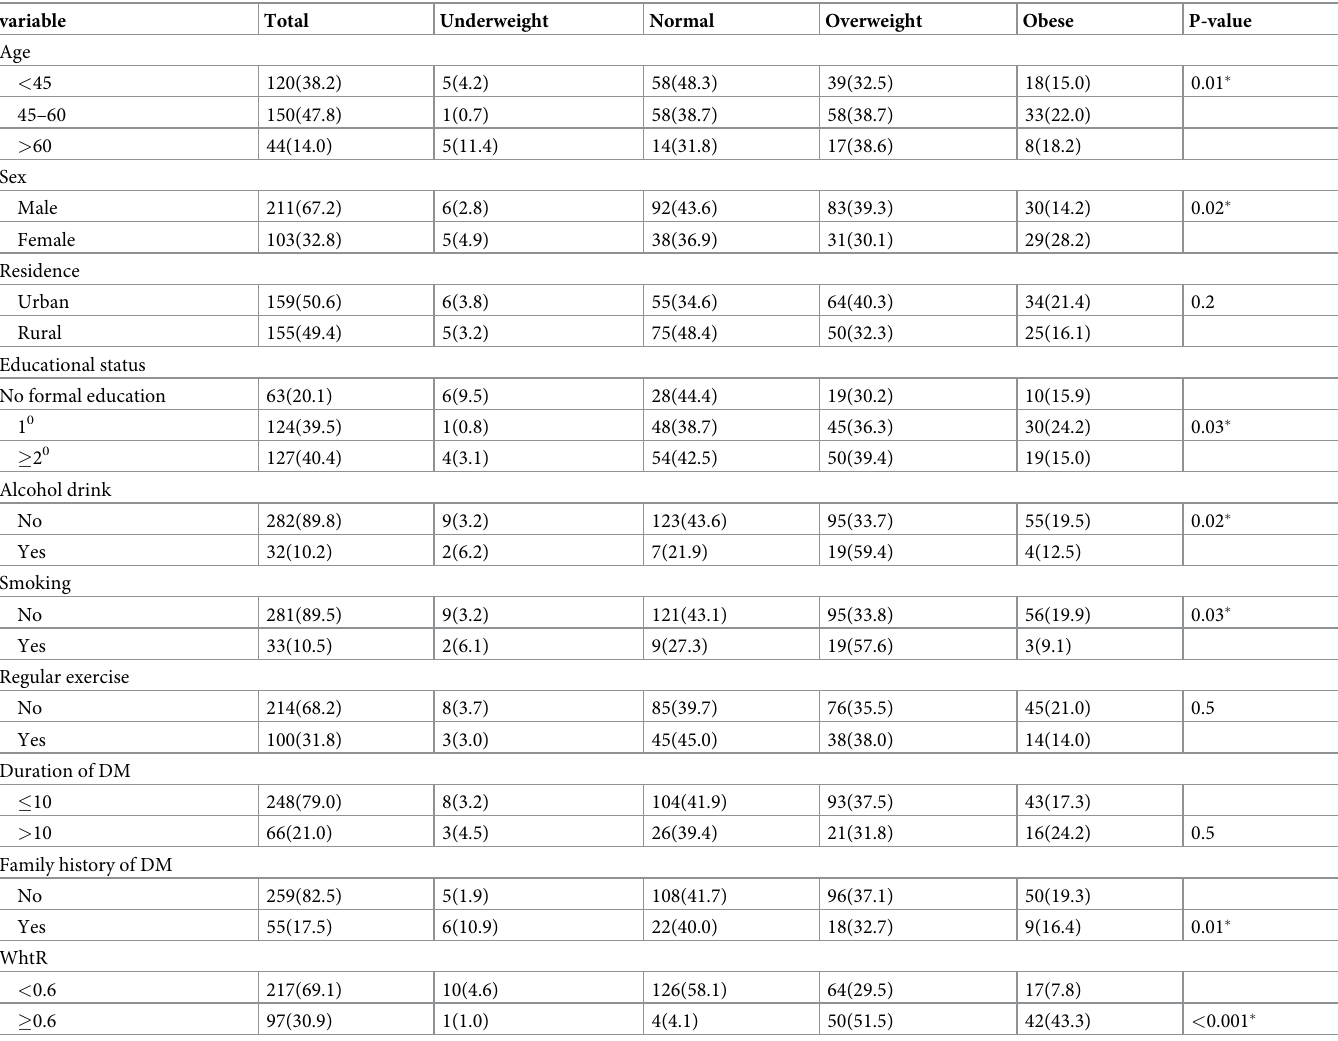
Table 1. Socio-demographic and clinical characteristics of the study participants stratified by BMI in patients with T2DM at HUCSH and YGH from Oct 16 to Dec. 21,